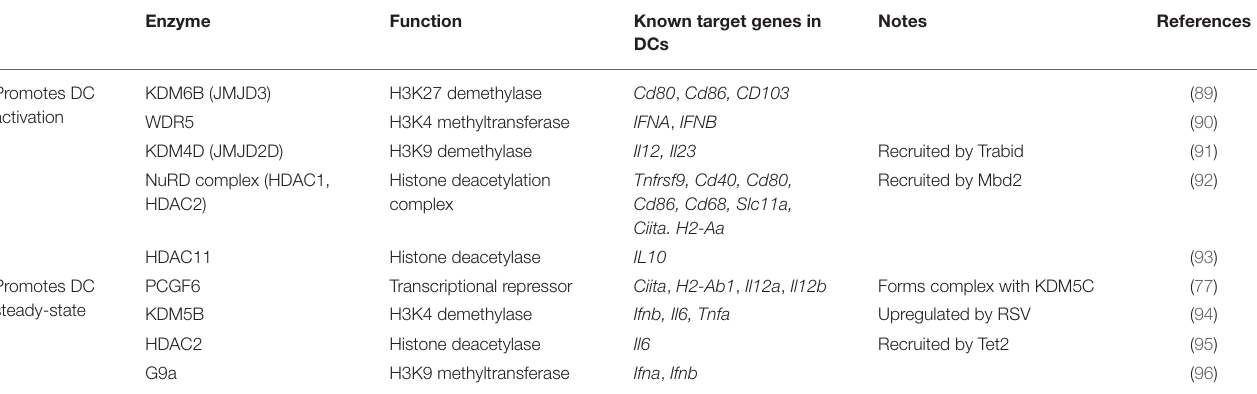
TABLE 2 | Epigenetic factors that influence DC activity. Enzyme Function Known target genes in